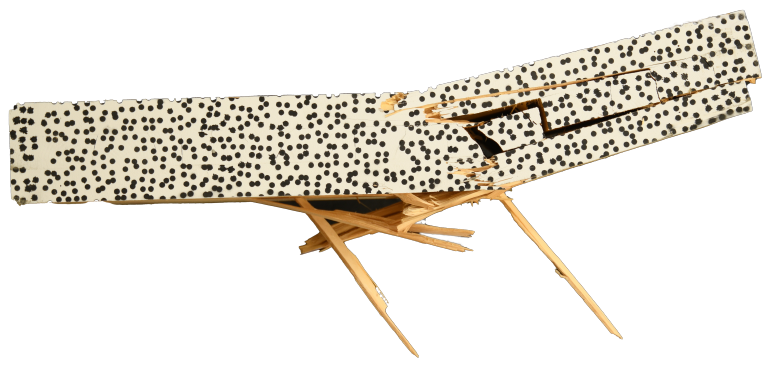
Figure 27. CLT3-5 Post dynamic